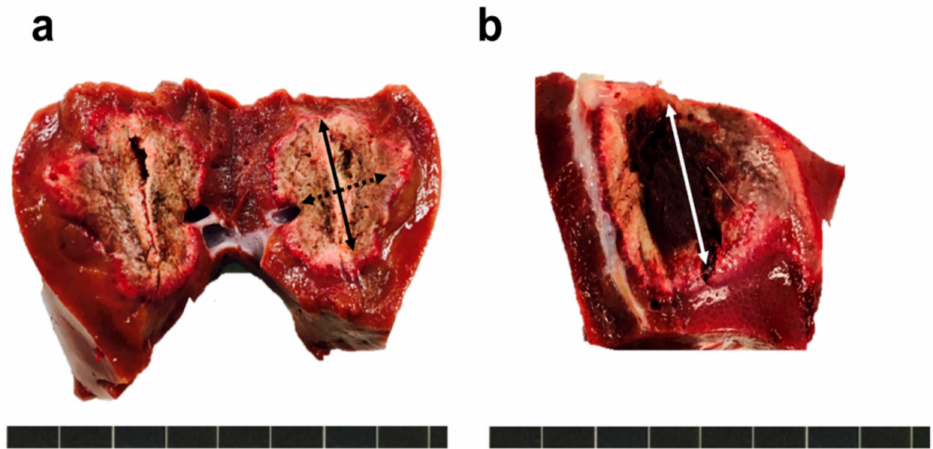
Figure 4. The elliptical shape of a radiofrequency ablation (RFA) zone created by the drug-releasing cooled wet electrode. ( a ) A specimen in the electrode insertion axis. D max and D min indicate maximum diameter (black solid arrow) and minimum diameter (black dotted arrow). ( b ) A specimen in the transverse plane perpendicular to the electrode insertion axis. D v indicates vertical axis (white solid